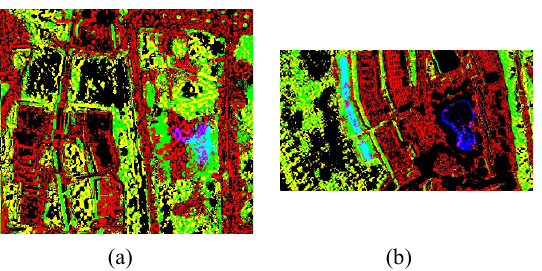
Figure 6. Change detection from the QuickBird image to the WorldView image of (a) “Scene 1” (b) “Scene 2” after 13 years have passed: Red = buildings, Green = vegetation, Blue = water, Yellow = buildings and vegetation, Magenta = buildings and water, Turquoise = vegetation and water, Black: no change or ground (proposed technique). The classified multi-temporal images of Figure 2 have been utilized.